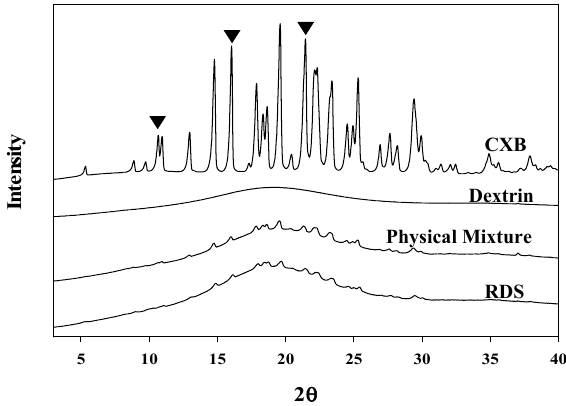
Figure 4 . X-ray diffractograms of CXB powder, dextrin, physical mixture, and RDS.